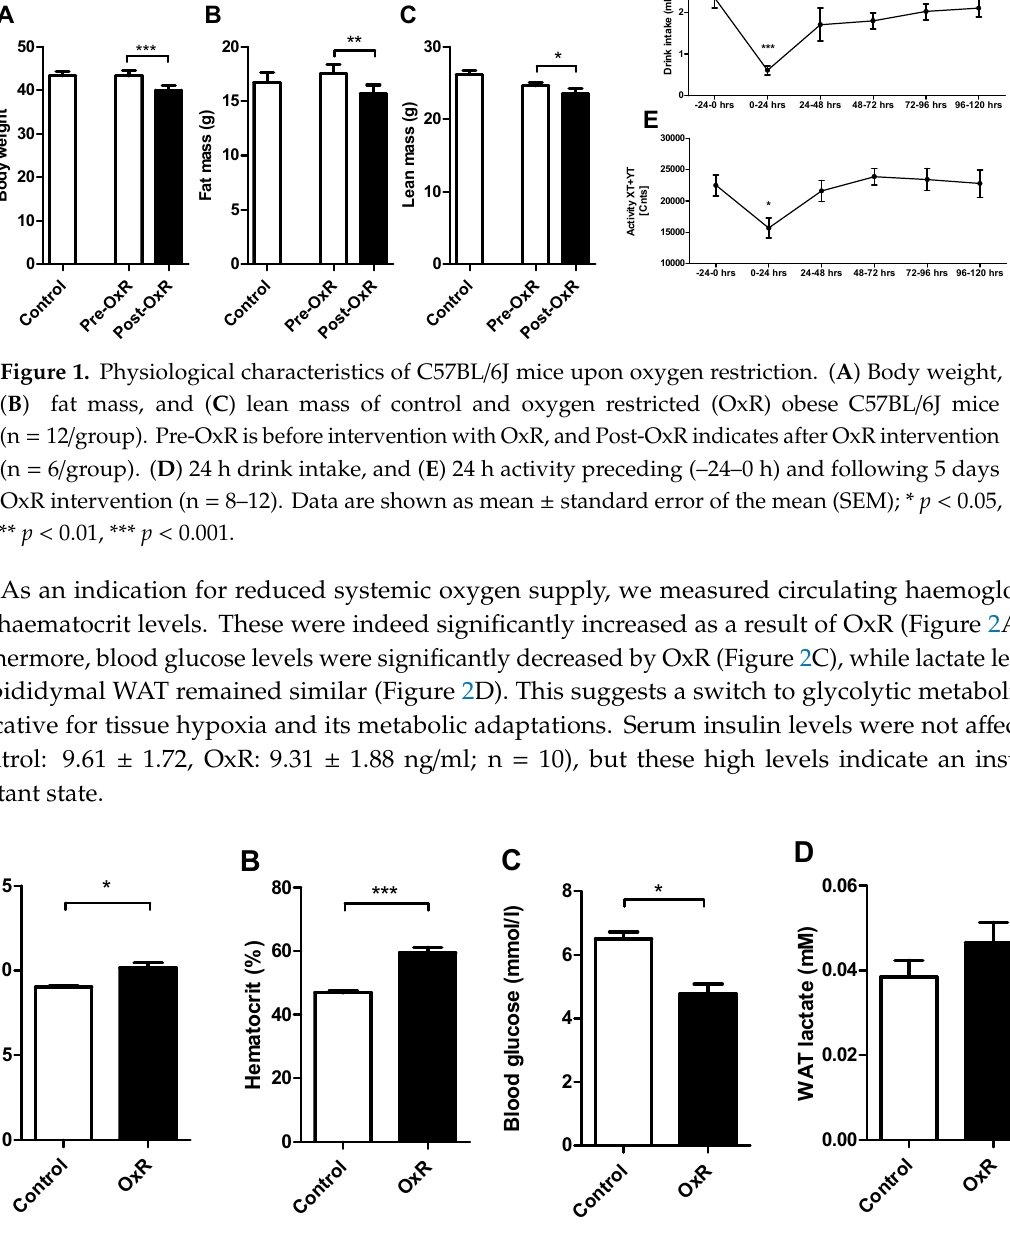
Figure 2. Metabolic effects of oxygen restriction (OxR) intervention. ( A ) OxR increased hematocrit (n = 1 2), and ( B ) hemoglobin levels (n = 5–6) in blood, ( C ) decreased blood glucose levels (n = 12), without ( D ) eWAT changes in lactate levels (n = 10). Data are shown as mean ± SEM; * p < 0.05, *** p < 0.0001.